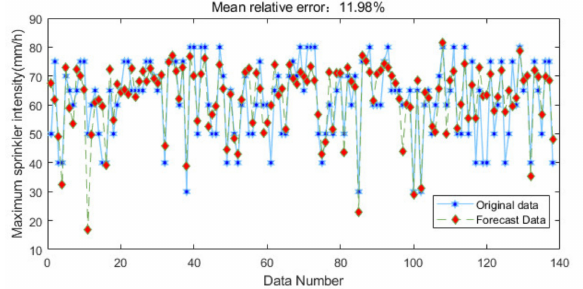
Figure 7. The smoothness parameter of the RBF neural network is